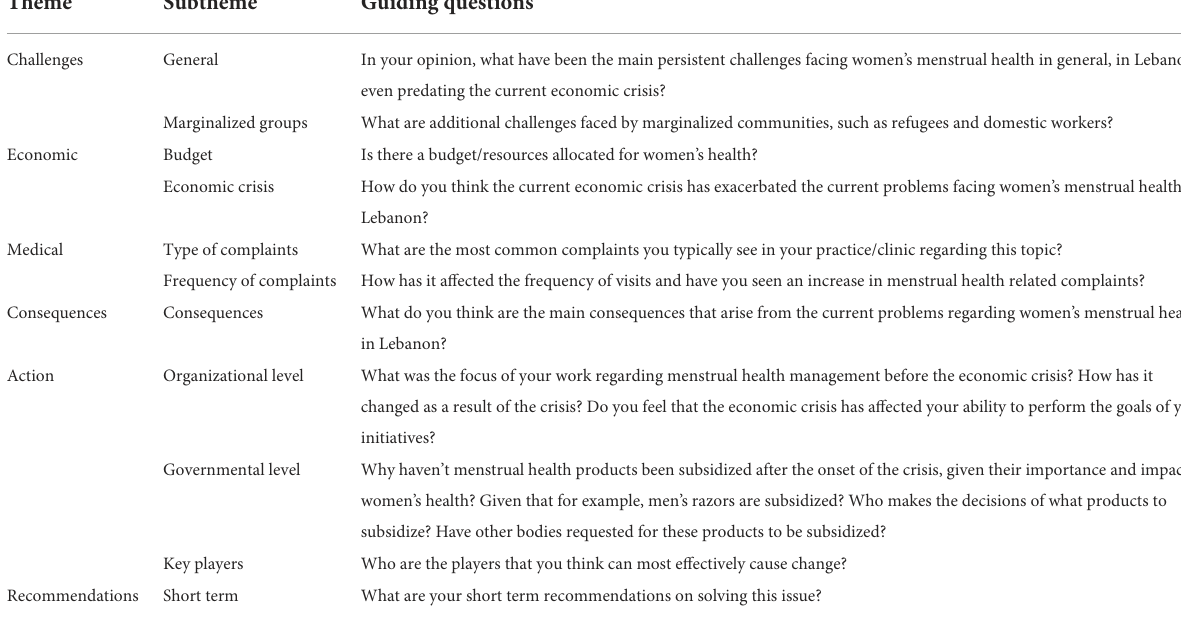
TABLE 1 Themes, subthemes, and corresponding guiding questions.